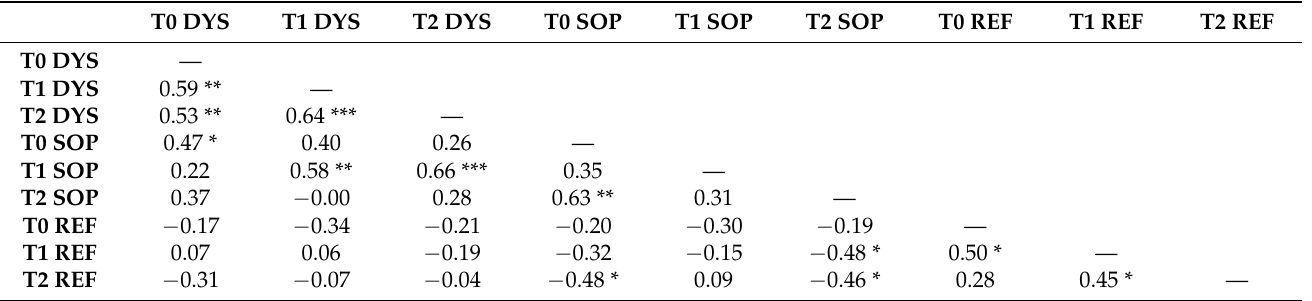
Table 4. Pearson Correlation Coefficients between Emotion Regulation Strategies at T0, T1, and